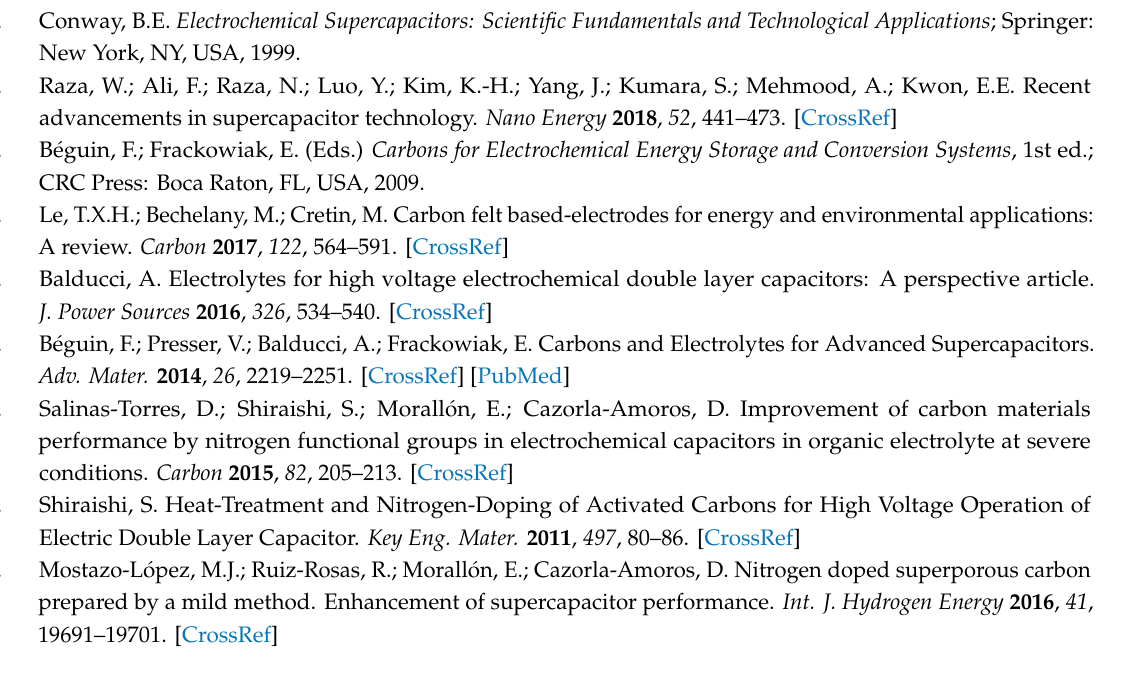
Figure S1. Di ff erential pore size distributions obtained by NL-DFT calculations for all activated carbons; Figure S2. GCD curves obtained for EDLCs (activated carbons-based symmetric capacitors). 1M TEMABF4 / PC. j = 1000 mA / g. V = 2.5V;FigureS3. N1sXPSspectrumobtainedforYP50F-Nactivatedcarbon; FigureS4. N2adsorption-desorption isotherms of the activated carbons YP50F and YP50F-N; Figure S5. Cyclic voltammograms in the potential range between 0V and 0.6V for YP50F and YP50F-N electrodes. 1M H2SO4. V = 1 mV / s; Figure S6. Evolution of capacitance and coulombic e ffi ciency during the durability test for YP50F and YP50F-N based capacitors. 1M TEMABF4. j = 40 mA / g; Table S1. Textural properties and elemental surface composition (XPS and TPD) for YP50F and